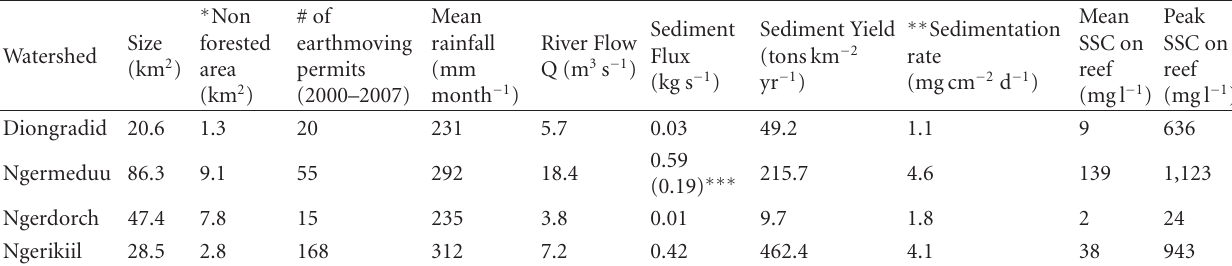
Table 1: Summary of physical parameters and sediment rates at the four watershed study sites.